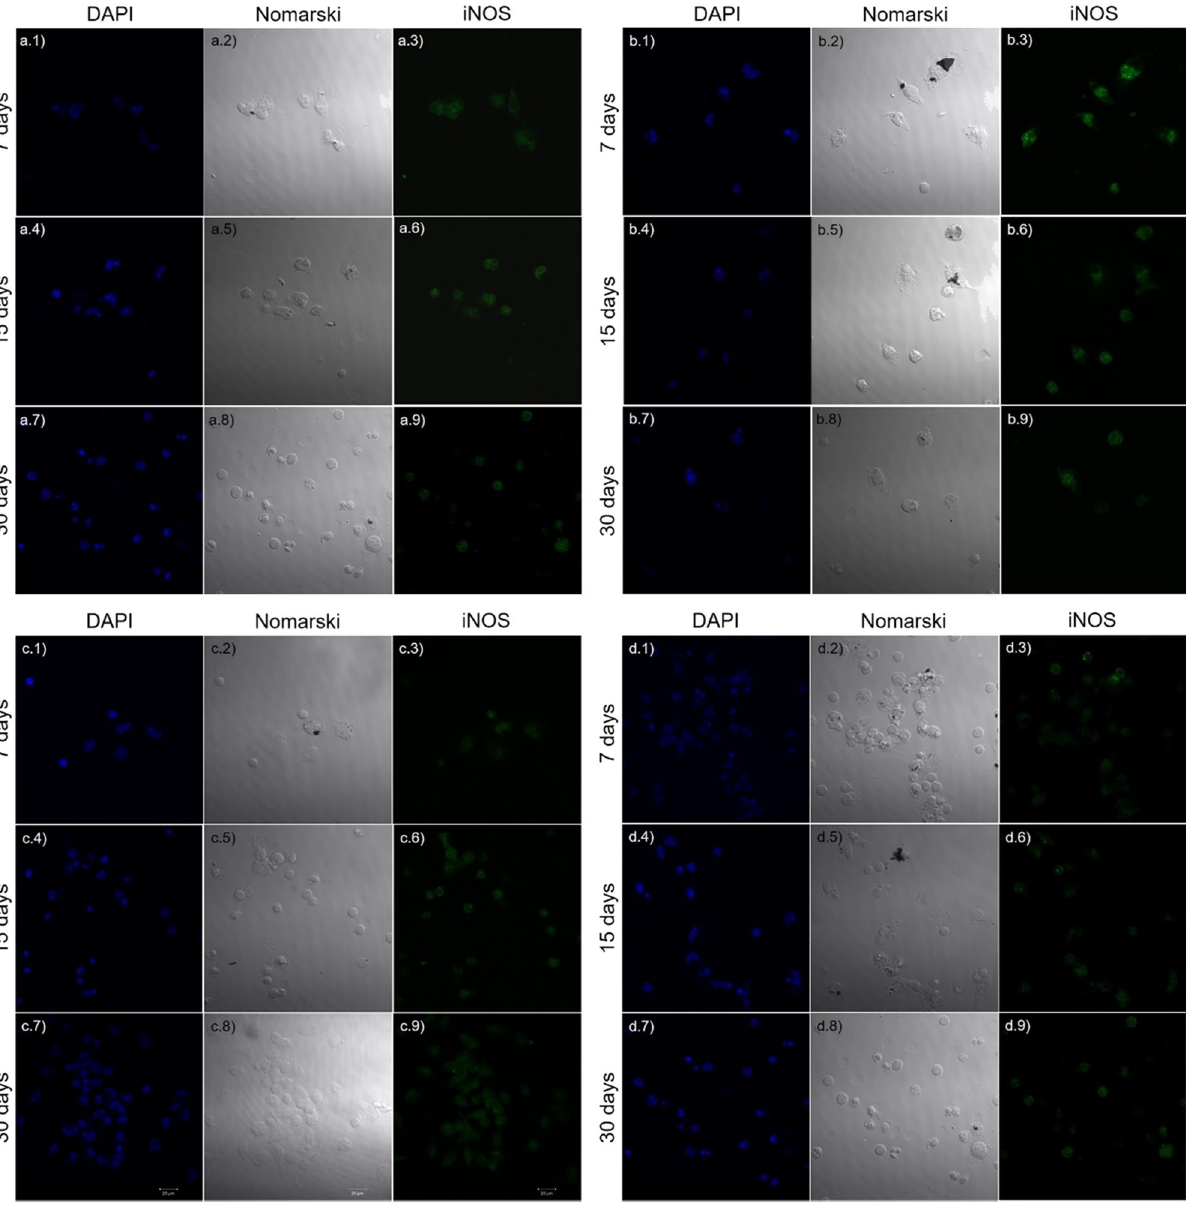
column; Differential interference contrast microscopy, also known as Nomarski microscopy, in the central column; and iNOS (green), in the right column. Magni fi cation